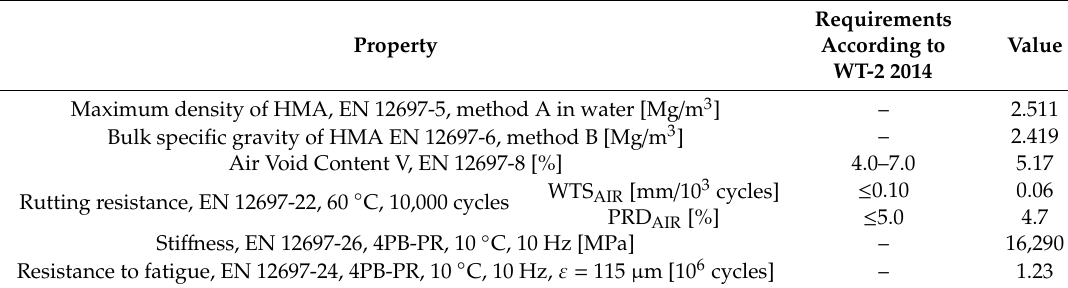
Table 3. Properties of the AC 16 W 35/50 mixture.